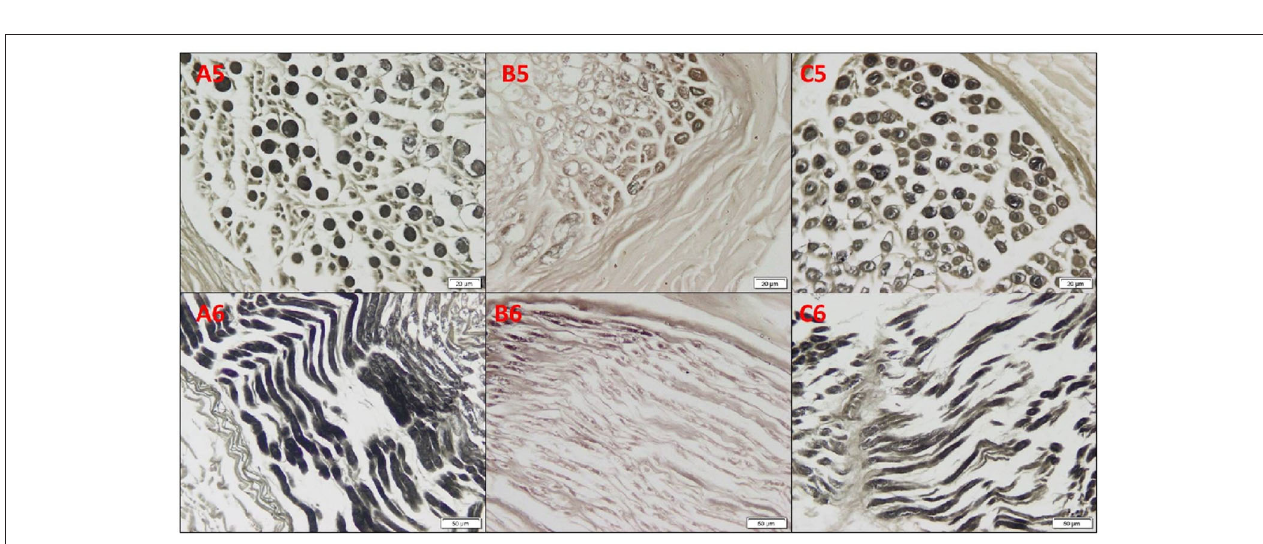
FIGURE 3 | Photomicrographs of the cadaveric median nerve sections for demonstrating myelin sheath in transverse sections in (A5, B5, C5) and in longitudinal sections in (A6, B6, C6) of the group A arm, group B forearm, and group C wrist, respectively, revealing apparently normal myelin sheath stained black in the arm and wrist, and with a diminished staining in the forearm (osmium oxide, ×